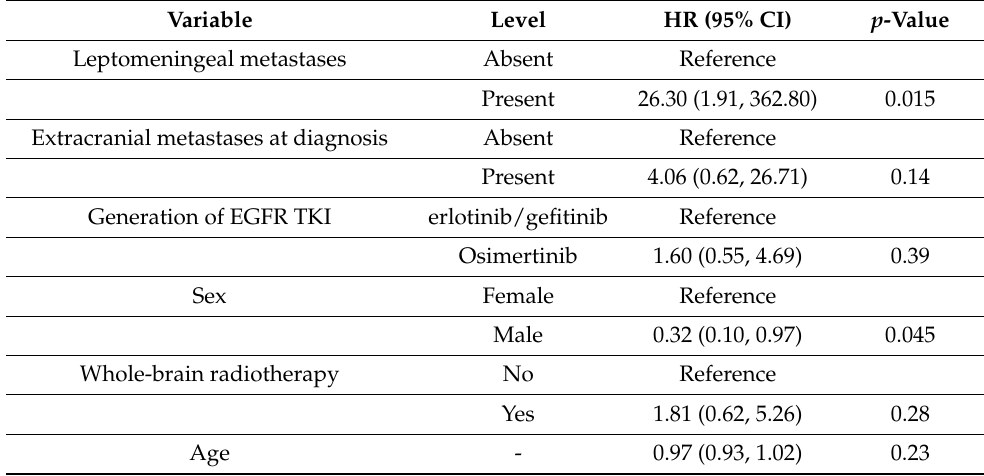
Table 7. Multivariable Cox-Proportional Hazards Modeling of overall survival (OS) for EGFR-altered NSCLC patients with brain metastases in 2nd-to-5th-line EGFR-TKI.